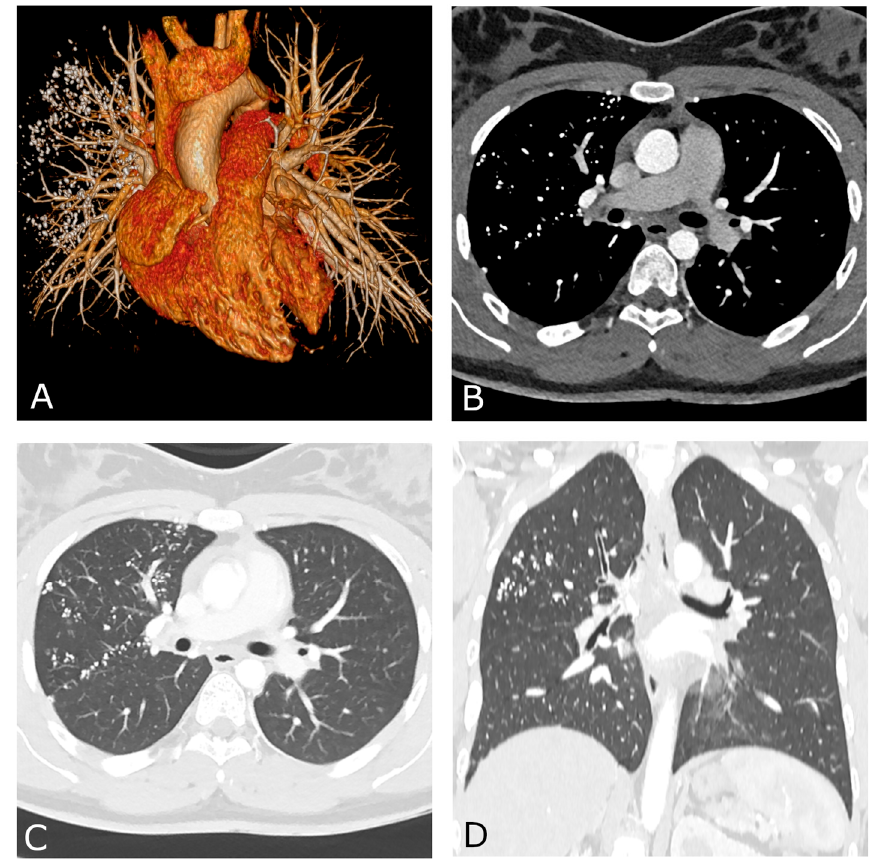
Figure 1. Chest CT angiography with ECG gating performed on a dual-layer DECT platform. Volume- rendering reconstruction ( A ) shows normal cardiovascular anatomy with multiple high-density foci within the right lung. Both axial ( B , C ) and coronal reconstructions ( D ) demonstrate the typical perilymphatic distribution of the lung nodules. Mediastinal ( B ) and lung parenchyma ( C ) views performed along the same axial plane are